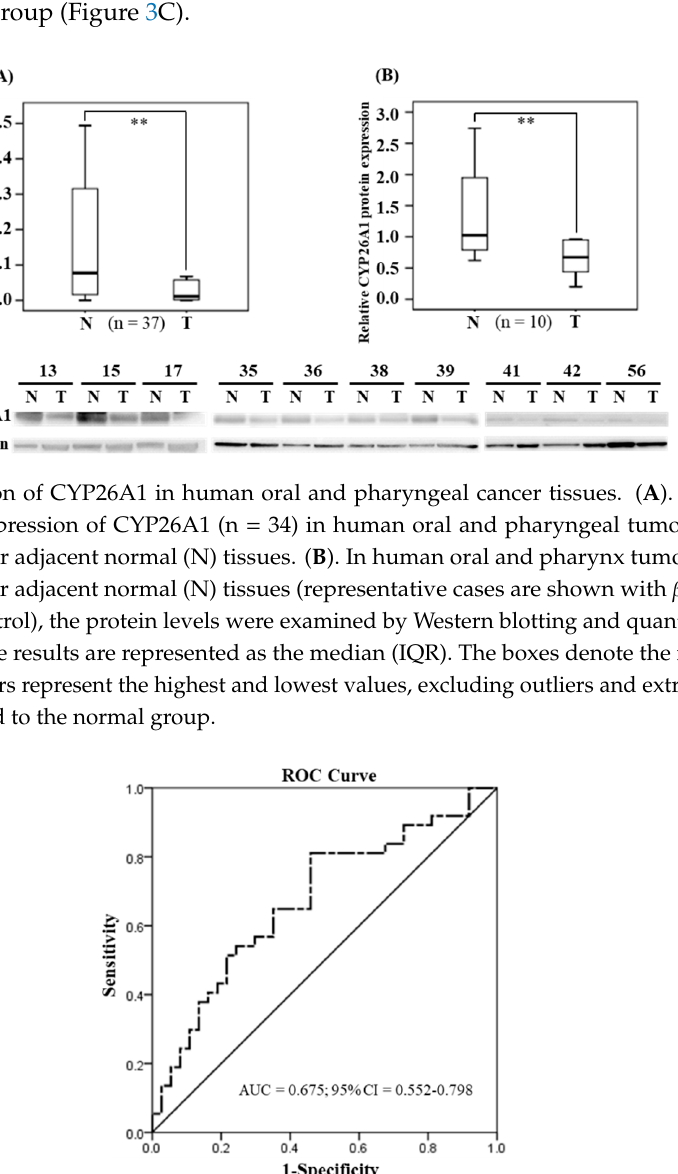
Figure 2. Receiver operating characteristic (ROC) curve analysis of the 2 −ΔΔ Ct scores of mRNA in human oral and pharyngeal tumor (T) tissues (n = 37). The area under the curve (AUC) = 0.675 (95% confidence interval (CI) = 0.552–0.798; p = 0.01 < 0.05) was used to differentiate the 2 −ΔΔ Ct scores <0.069 for tumor tissues from the 2 −ΔΔ Ct scores ≥ 0.069 for adjacent normal tissues .